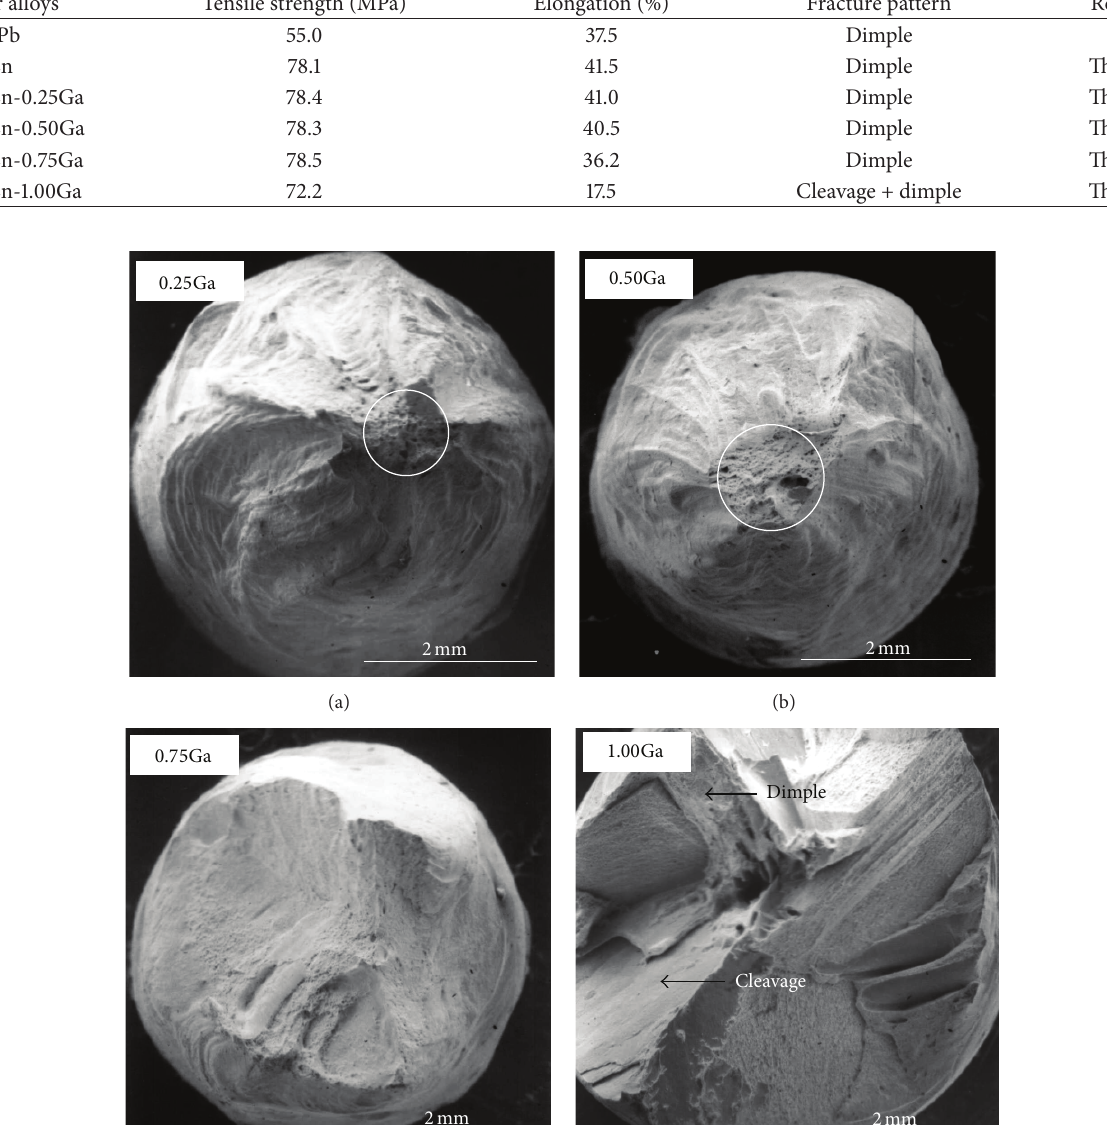
caused by 1.0 Ga additions to the Sn-9Zn alloy is due to a fraction of the Sn/Zn eutectic region decreasing, the Sn- matrix region increasing, and the needle-like Zn-rich phase becoming coarser and longer. The Ga-Zn phase diagram [31] shows that hexagonal (Zn) solid solution possesses a maximum solubility of 2.36 at.% Ga at 260 ∘ C. Meanwhile, Sn exhibits [32] a maximum solubility of 7.1 at.% Ga. Thus, most of the Ga is dissolved in the Sn-rich and Zn-rich phases. The atomic radii of tin, zinc, and gallium have nearly the same size. Thus, when Ga is added to the Sn-9Zn alloy, it may form a solid solution structure. It is believed that